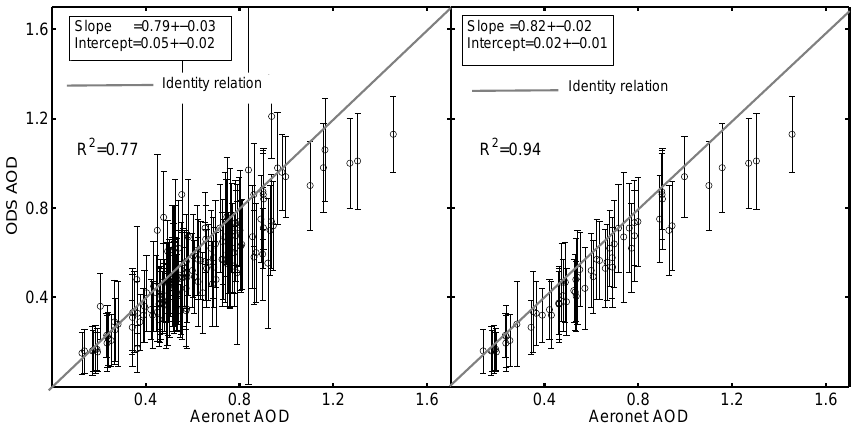
Figure 14. (a) Correlation between ODS blue channel and AERONET AOD at 370nm for the whole data set, where the ODS error bars represent the asymptotic standard parameter. (b) Same as (a) but for cloud-free days